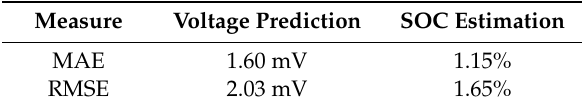
Table 2. Performance of the proposed method on voltage prediction and SOC estimation for the hybrid pulse experiment.